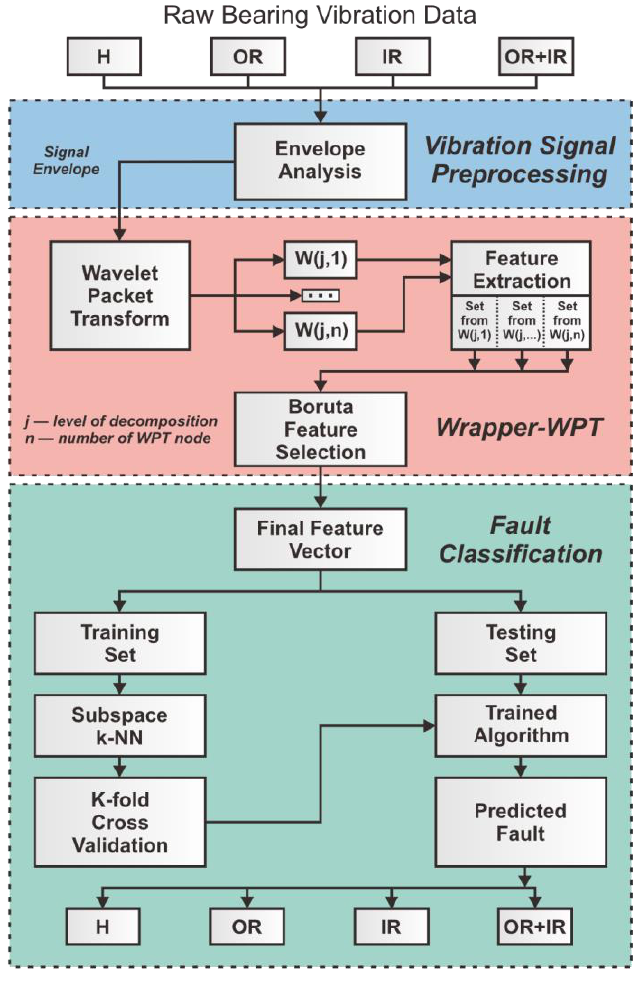
Figure 4. The pipeline of the proposed methodology.